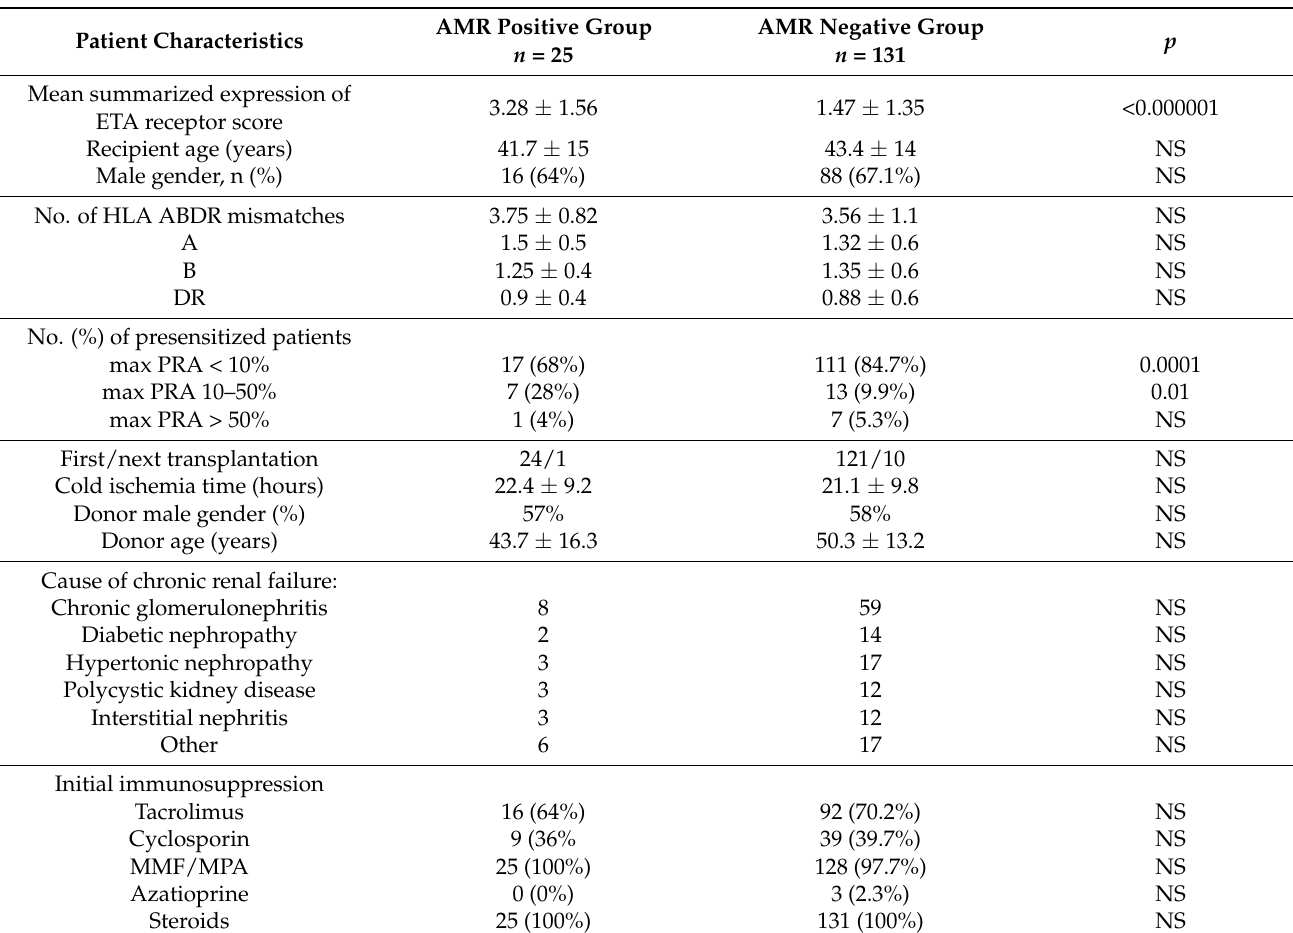
Table 1. Characteristics of the patients according to the presence of